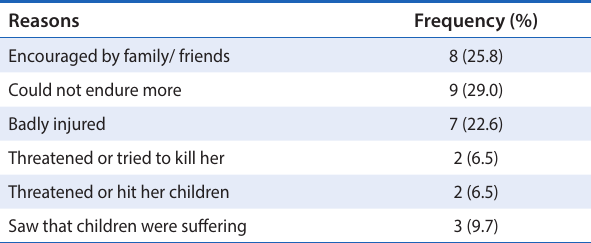
Table 7: Respondents’ reasons for seeking help ( n = 31)